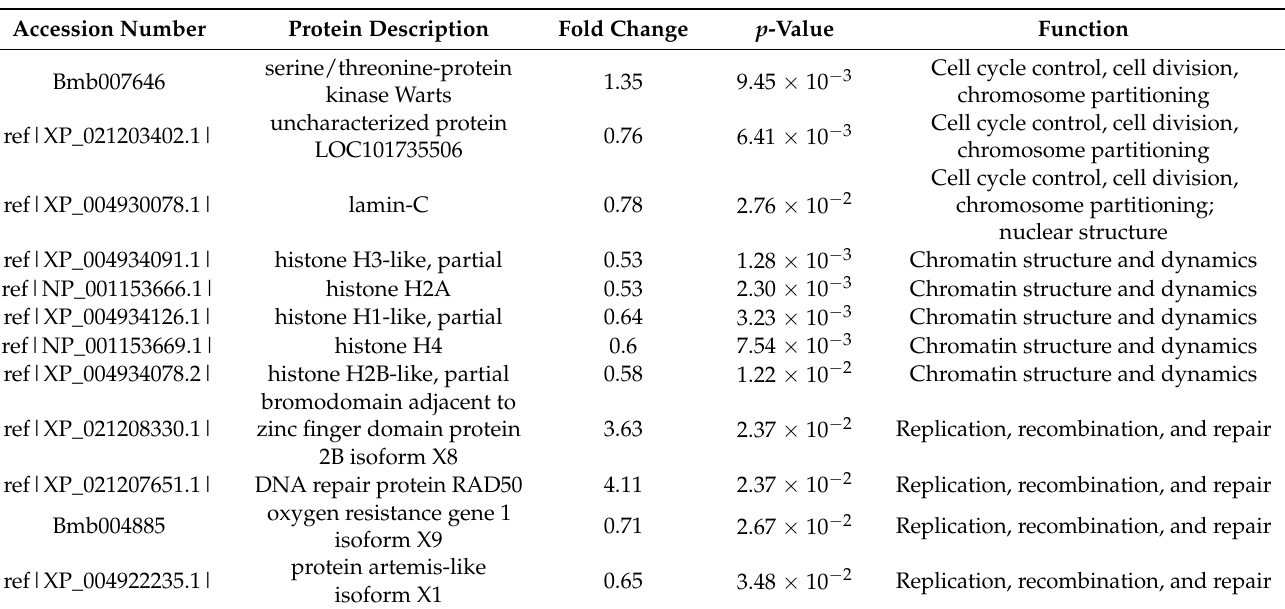
Table 1. The cell cycle-related differential abundance proteins (DAPs) after thermal induction.